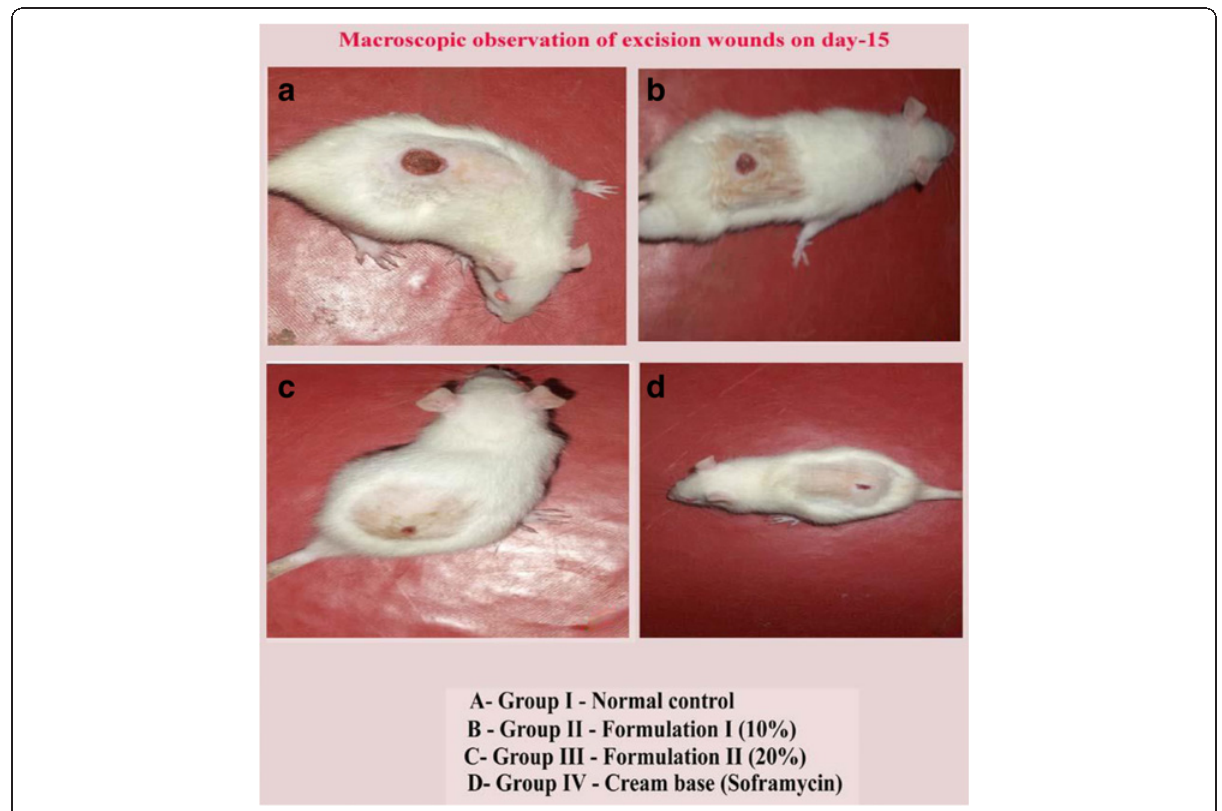
Fig. 1 Photographical representation of wound